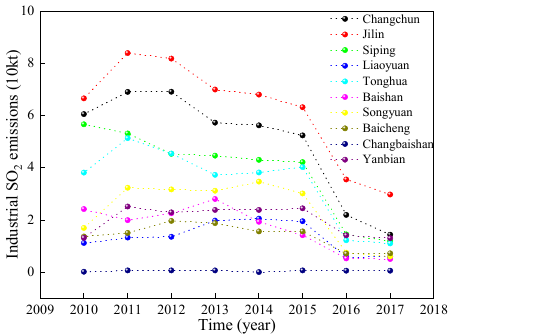
Figure 3. SO 2 emissions from urban emissions in Jilin Province. Figure 4 shows the seasonal variation of SO 2 concentration in different cities. There is a pattern in the seasonal variation of the SO 2 concentration across all the cities, where the SO 2 concentration values follow the order of winter > autumn > spring > summer. Overall, a decreasing trend with the annual fluctuations was observed, and the variation was the lowest after 2018.